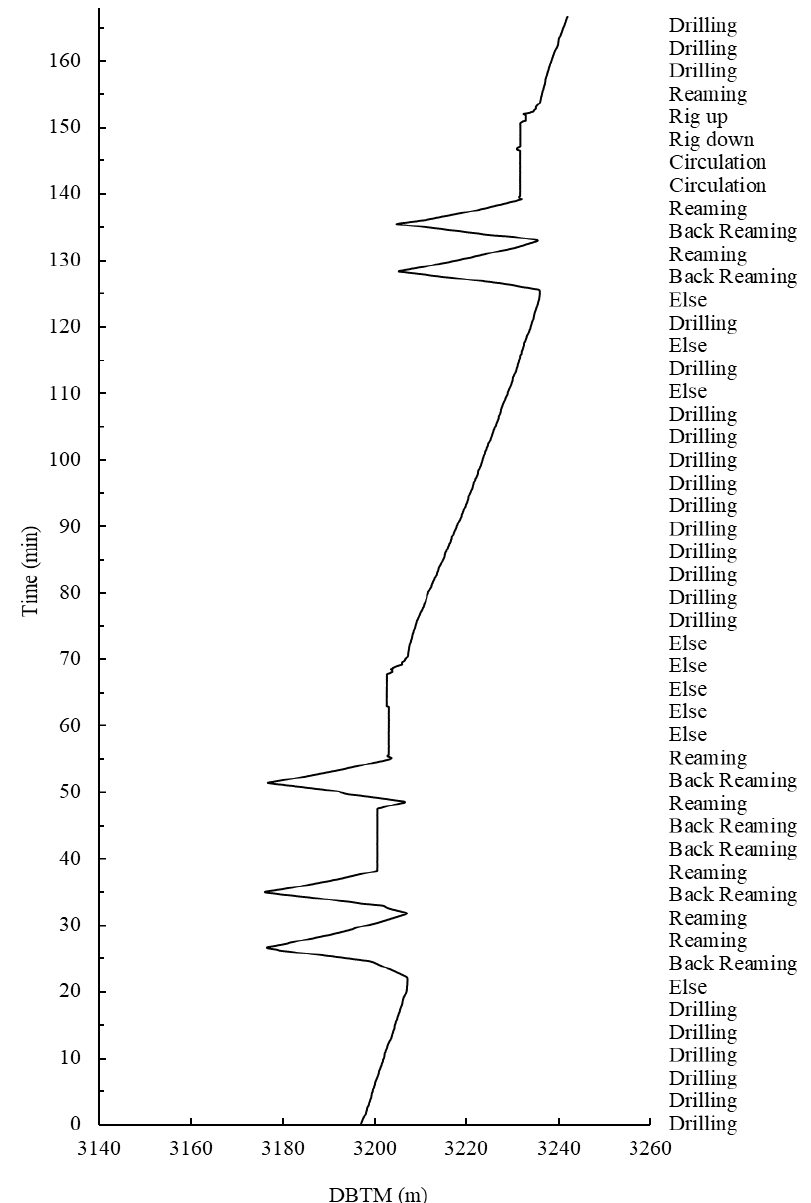
Figure 4. Schematic diagram of drilling condition identification based on Stacking fusion model.